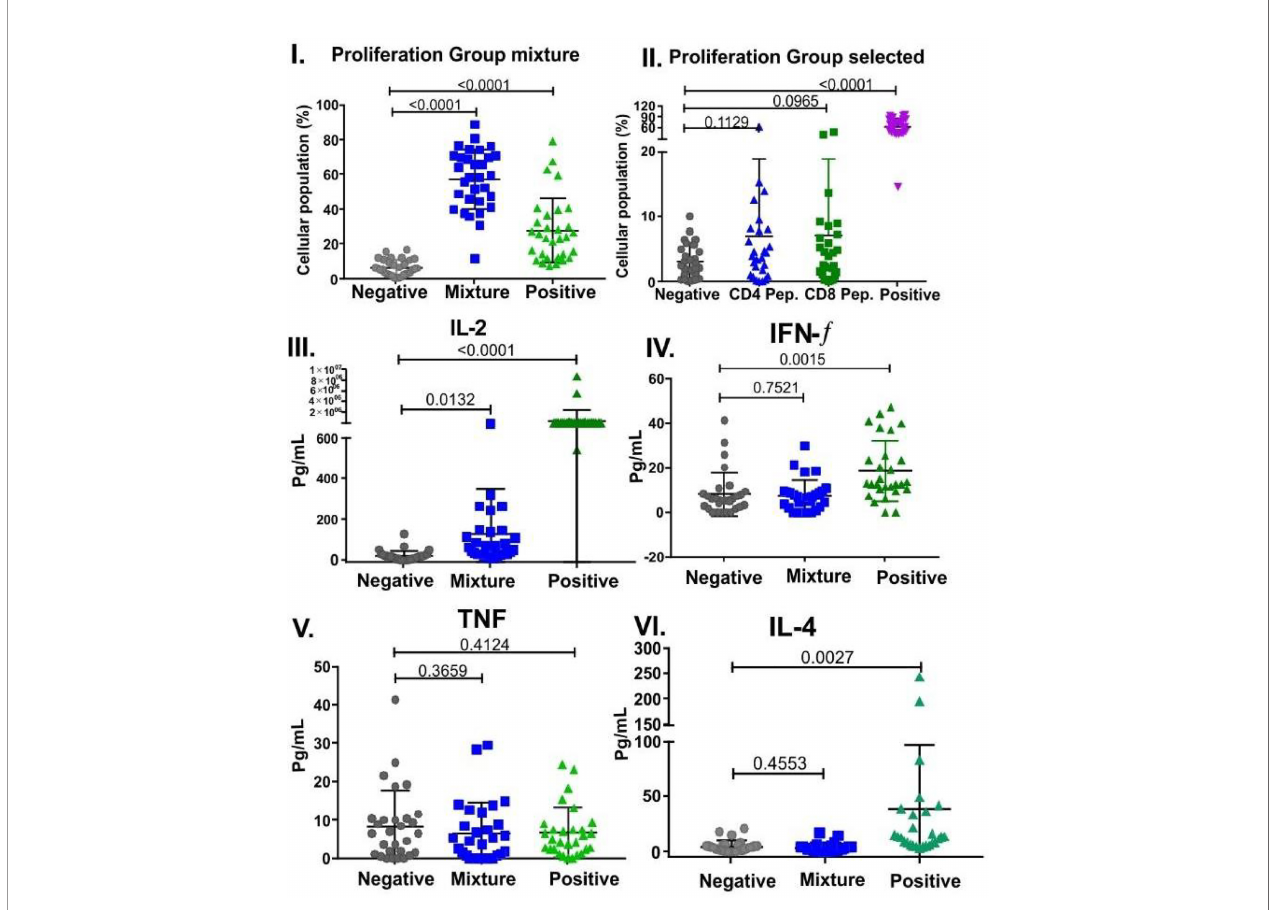
FIGURE 12 | Selected peptides and cytokines ’ cell proliferation in B-21 (50 peptide mixture) and C-21 trials (53 peptides). Mann – Whitney and Student ’ s t-tests were used for assessing statistically signi fi cant differences between negative control (culture medium) and a mixture of peptides to stimulate CD4 + T cells: (I). Group mixture (II). Selected peptides, showing individual Aotus spp. percentage CD4 + and CD8 + T cells (n = 29 for each group). CD4 + T cells were labelled with FITC mouse anti- Aotus antibody and Paci fi c Blue mouse anti- Aotus CD45RO + (in-house), and CD8 + T cells with anti-mouse FITC-conjugated CD8 + T cells (RPA-T8, BD clone) and Paci fi c Blue mouse anti- Aotus CD45RO + . Statistically signi fi cant differences between negative control and CD4 + T cells, group mixture ( p < 0.0001) and selected group ( p = 0.1129), CD8 + T cells ( p = 0.0965), and positive control ( p < 0.0001) are shown for both groups. Cytokine-related statistically signi fi cant differences between negative control (culture medium) and a mixture of peptides for stimulating individual Aotus spp. CD4 + T cells (n=29). (III-VI) P -values for IL-2 ( p = 0.0132), IFN- g ( p = 0.7521), TNF ( p = 0.3659), IL-4 ( p = 0.4553), IL-6 ( p = 0.6502), and IL-5 ( p = 0.3512). Individual cytokines ’ positive control p -value compared to those for negative control: IFN- g ( p = 0.0015), TNF ( p = 0.4124), IL-6 ( p = 0.0696), IL-5 ( p = 0.9156), IL-4 ( p = 0.0027), and IL-2 ( p <